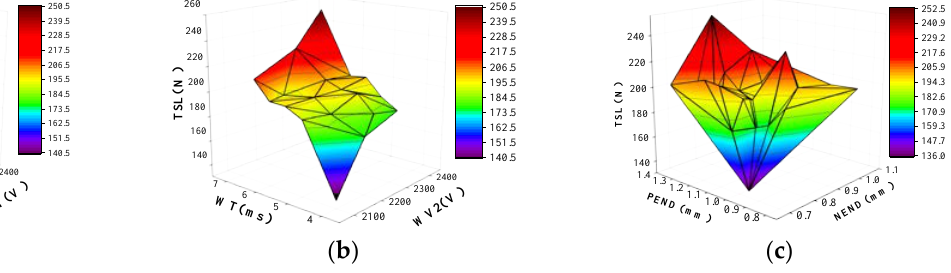
Figure 6. Correlation of welding process parameters and nugget diameter with tensile shear load. ( a ) Relationship between WV1 and WT on TSL; ( b ) Relationship between WV2 and WT on TSL; ( c ) Relationship between PEND and NEND on TSL.